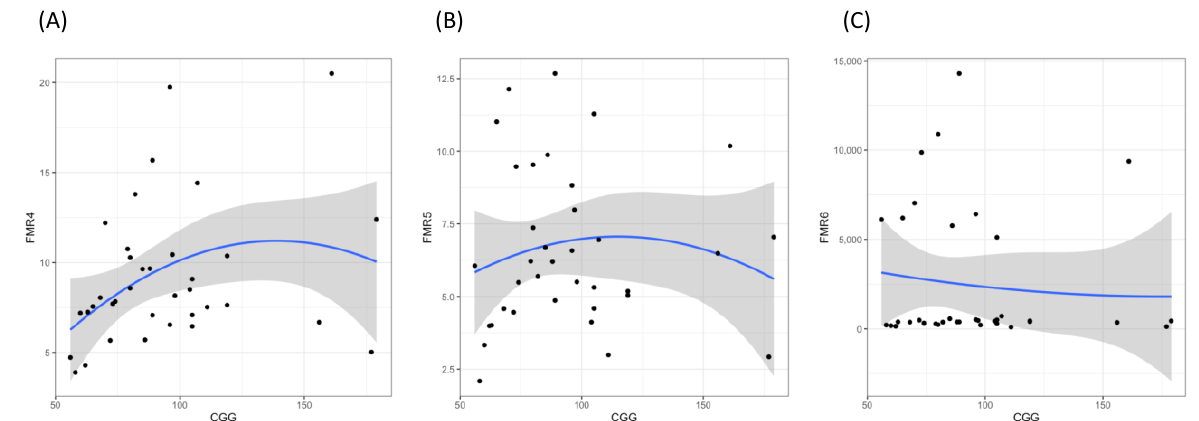
Figure 4. lncRNAs expression level in peripheral blood of FMR1 premutation carriers according to the number of CGG repeats. ( A ) FMR4 expression levels, ( B ) FMR5 expression levels, and ( C ) FMR6 expression levels.